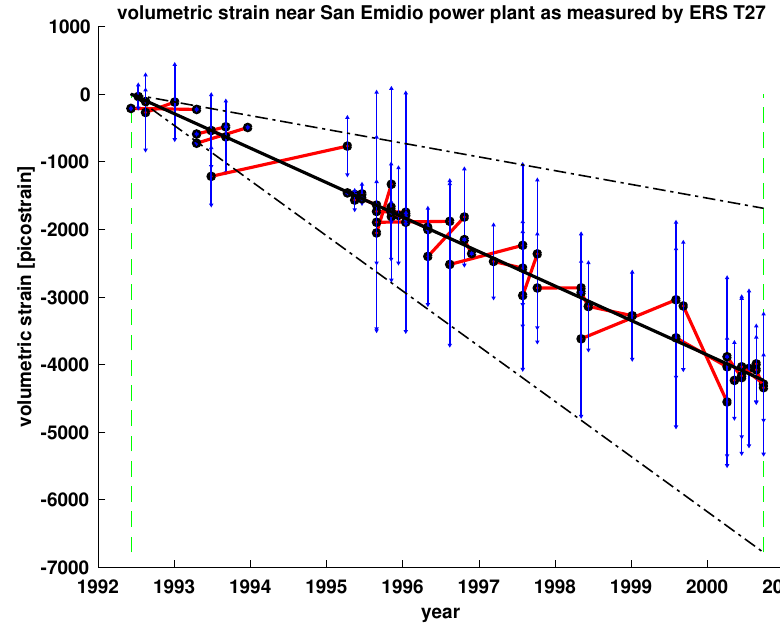
Figure A7. Cumulative strain near the San Emidio power plant as derived from temporal adjustment of mean strain rate values near the plant as measured by the ERS T27 MST data set. Plotting conventions as in Figure 6.